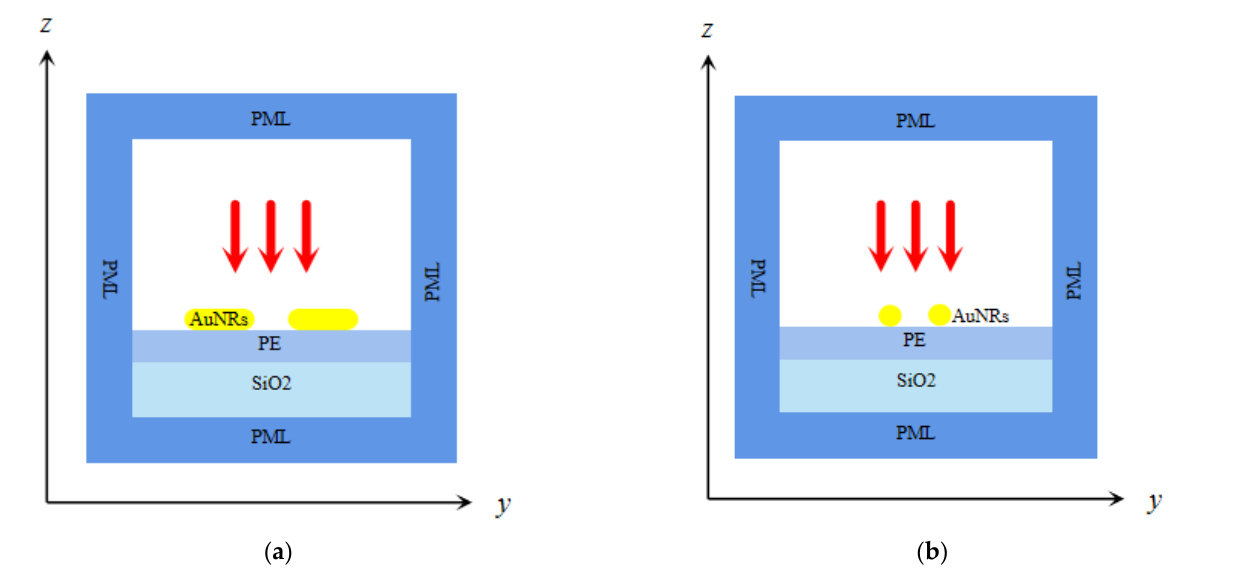
Figure 2. ( a ) The y-z section of the numerical simulation of the longitudinally arranged structure; ( b ) the y-z section of the numerical simulation of the side-by-side structure.